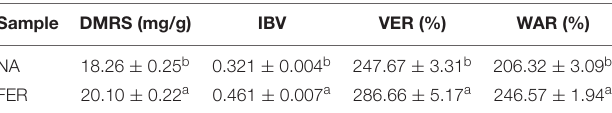
TABLE 4 | Cooking properties of broomcorn